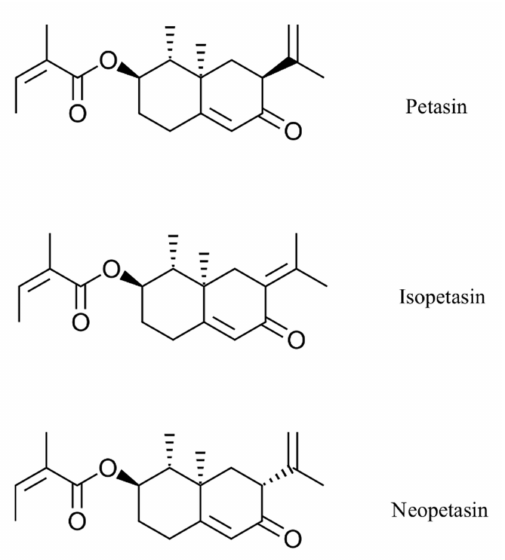
Figure 1. Chemical structures of the main petasins from Petasites hybridus . As shown in Figures 2 and 3, Ze 339, as well as petasin, isopetasin, and neopetasin, did not show any cytotoxic effect in this assay format up to concentrations of 20 µ g/mL (63.2 µ M for the petasines, respectively).